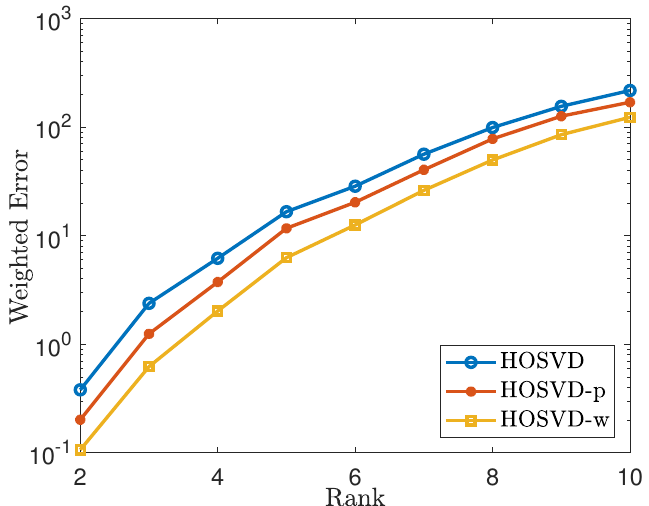
Figure 4. Tensor of size 50 × 50 × 30 × 30 using the non-uniform sampling pattern: plots the errors (cid:107)W ( 1/2 ) ( (cid:98) T −T ) (cid:107) F of the form . The lines labeled as HOSVD, HOSVD-p and HOSVD-w represent the (cid:26) (cid:107)W ( 1/2 ) (cid:107) F results for solving (4), (5) and (6),